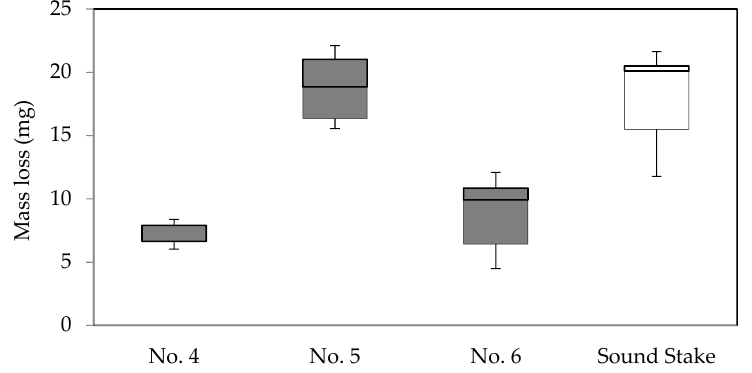
Figure 3. Comparison of the mass loss of oven- and air-dried specimens prepared from decayed stakes after termite feeding in the two-choice feeding tests. Sound specimens prepared from the sound part of the stakes ( open boxes ).